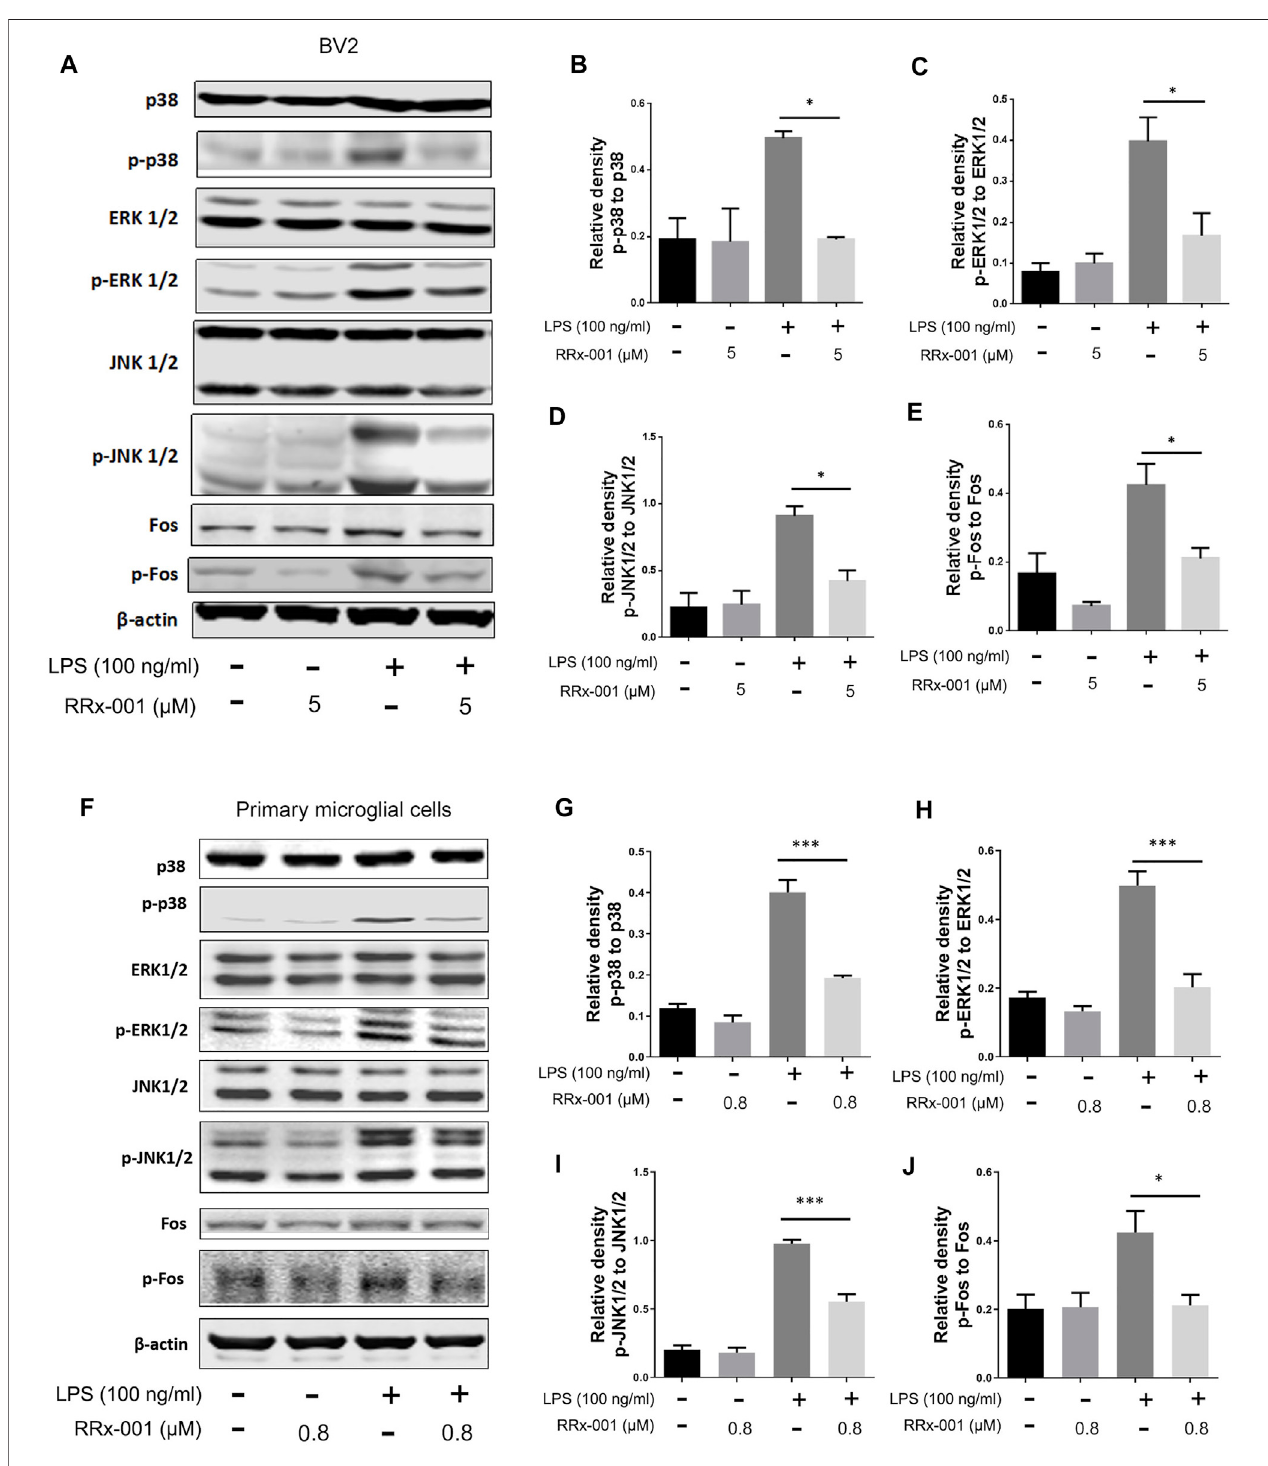
FIGURE 5 | RRx-001 inhibited LPS-induced the activation of MAPK signaling pathway. (A – J) The cells were treated in the same way as in Figure 4 . After the cells were harvested, the protein levels of p38, p-p38, ERK1/2, p-ERK1/2, JNK1/2, p-JNK1/2, Fos, p-Fos and β -actin were detected using western blotting assay. The relativeintensityofp-p38,p-ERK1/2,p-JNK1/2andp-Fos,respectivelyrelativetop38,ERK1/2,JNK1/2andFoswasquanti fi edinthebar fi gures.Thevaluesfromthree independentexperiments wereshownasthemeans±SEM.One-wayANOVAfollowedbyBonferroni ’ spost-hoctestwasusedformultiplecomparisonsbetween groups, * p < 0.05, ** p < 0.01, *** p < 0.001, **** p < 0.0001, compared with those treated with LPS alone.